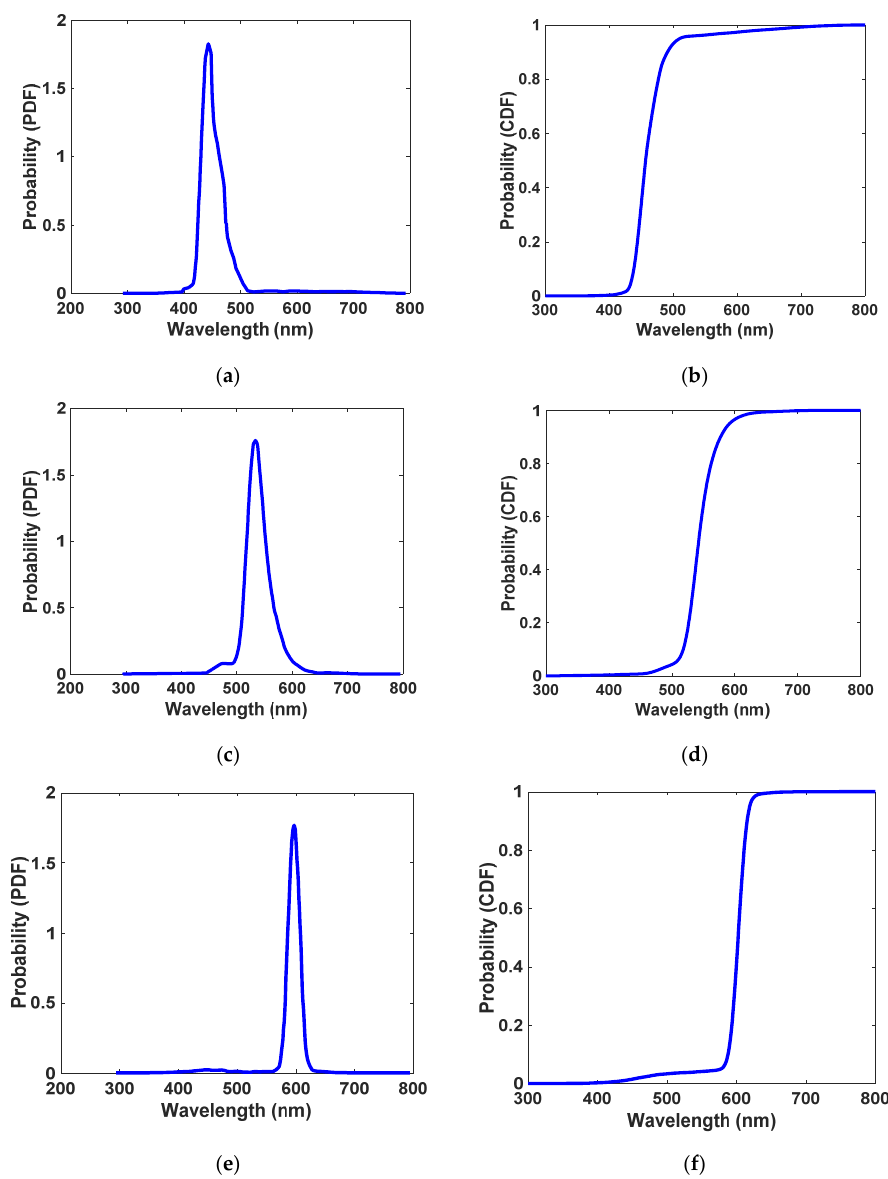
Figure 6. Probability density function (PDF) and cumulative density function (CDF) for quantum dot type A: Se/SiO 2 ( a , b ), quantum dot type B: CdS/SiO 2 ( c , d ), and quantum dot type C: Au/TiO 2 ( e , f ), respectively.